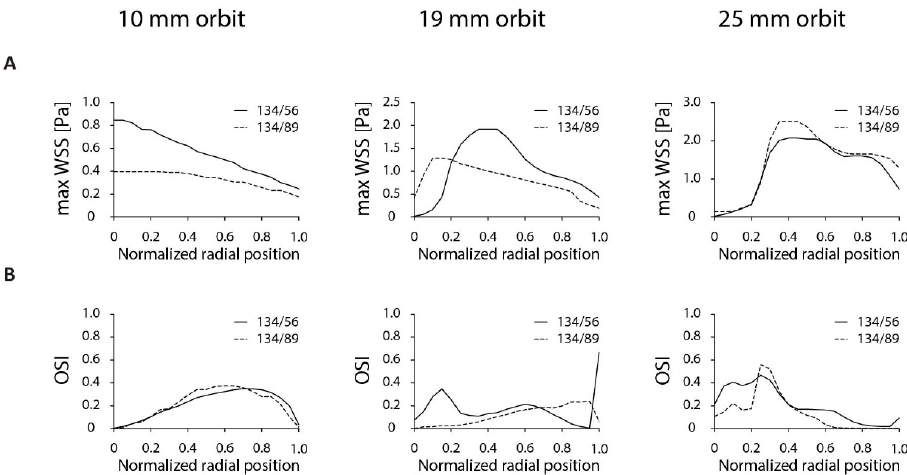
Figure 4. The effect of orbit size on shear stress distribution in the 134/56 and 134/89 design. ( A ) Maximum shear stress level at each radial position for the 134/56 and 134/89 annular dish on an orbital shaker with an orbit diameter of 10, 19 or 25 mm. For the calculations, a 3-mm fluid height and 200-rpm rotational speed was used. ( B ) OSI as a function of the radial position. Heat maps of the shear stress distributions can be found in Figure S2.